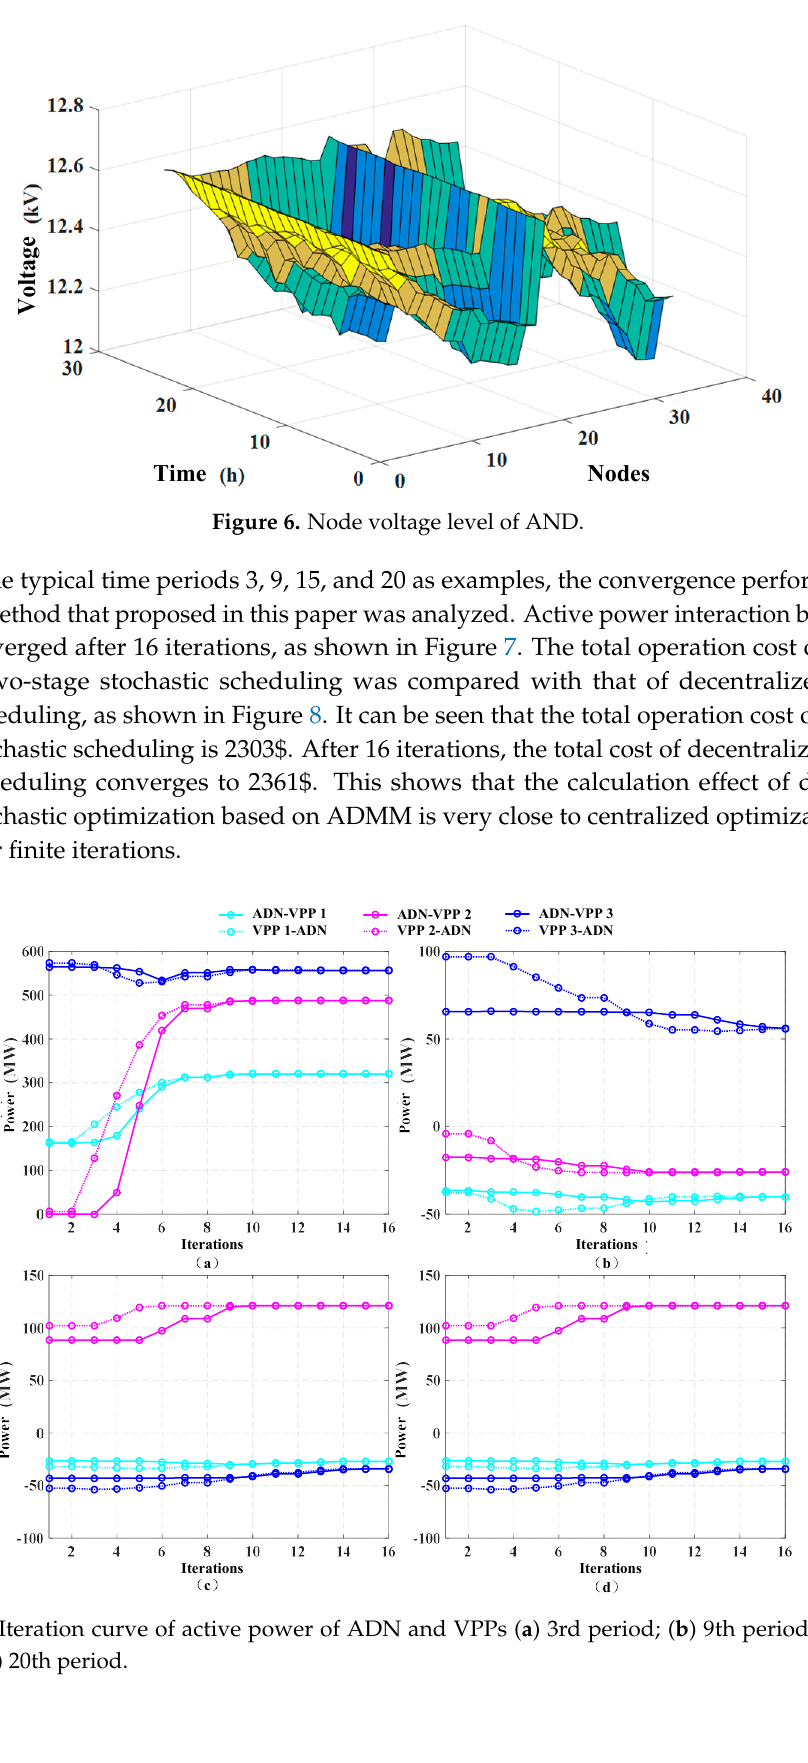
Figure 8. Convergence of total generation cost. In order to verify the effectiveness of the decentralized two-stage stochastic optimization model for active distribution systems with multi-virtual power plants proposed in this paper, the following four comparison situations are set up. Case 1: Without considering the stochastic uncertainty of distributed wind and light power output, the traditional centralized scheduling method is used to solve the problem. Case 2: Considering the stochastic uncertainty of distributed wind and light power output, the traditional centralized scheduling method is used to solve the problem. Case 3: Regardless of the stochastic uncertainty of distributed wind and light power output, a distributed scheduling method based on ADMM is adopted to solve the problem. Case 4: Considering the stochastic uncertainties of distributed wind and light power output, a distributed scheduling method based on ADMM is adopted to solve the problem, i.e., the two-stage stochastic optimization method proposed in this paper. The results of the four cases are shown in Table 2.